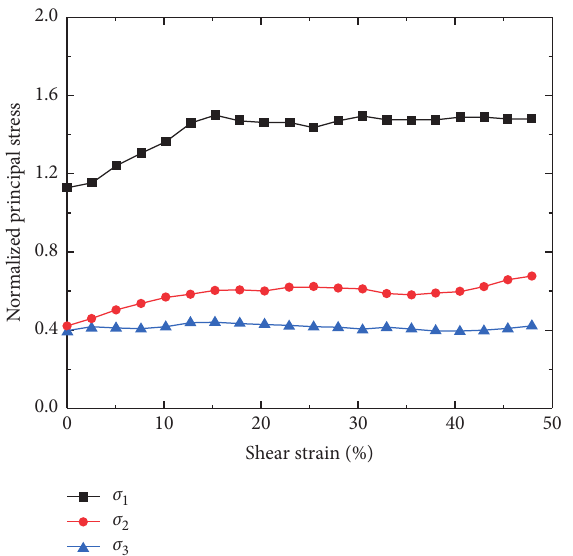
Figure 14: Principal stress and shear strain relations.